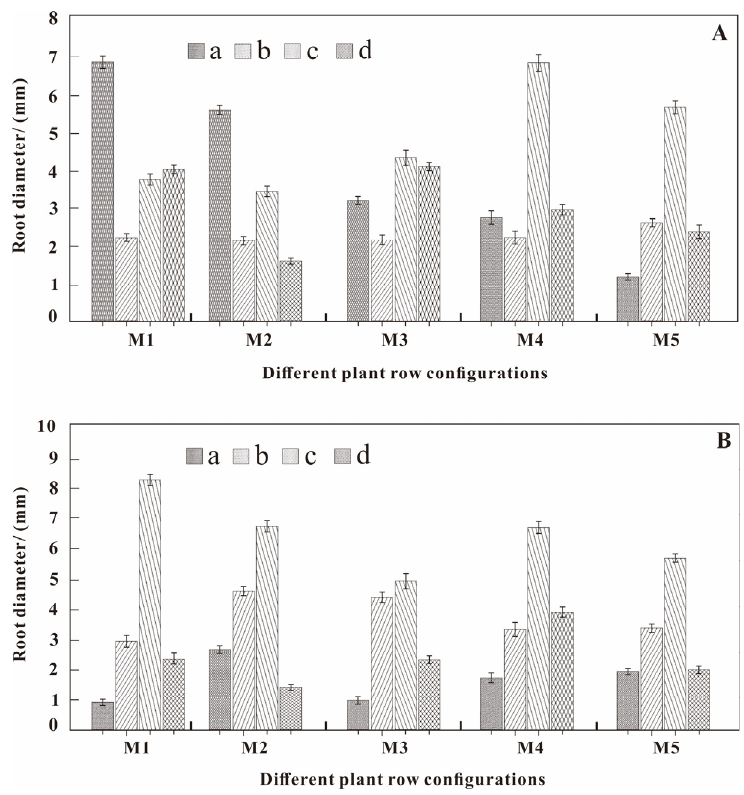
Figure 4. Distribution characteristics of root diameter area at different growth stages (a: Overwin- tering, b: Jointing, c: Heading, d: Ripening). ( A ) Multi-spike wheat. ( B ) large-spike wheat.